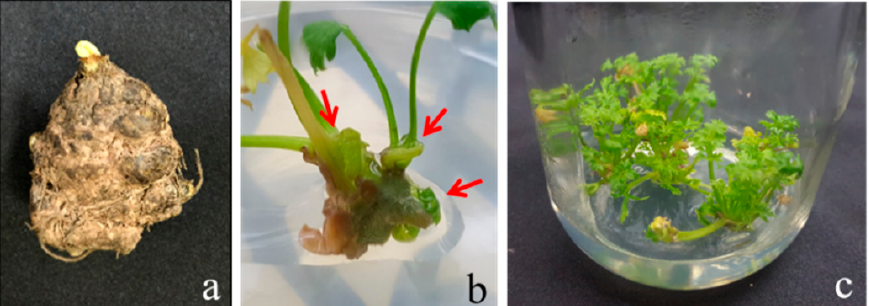
Figure 1. In vitro regeneration of Cnidium officinale plants on MS medium with 0.5 mg·L − 1 benzyl adenine (BA) and 30 g·L − 1 sucrose: ( a ) rhizome, ( b ) shoot development (arrows denote multiple shoots), and ( c ) plantlets.